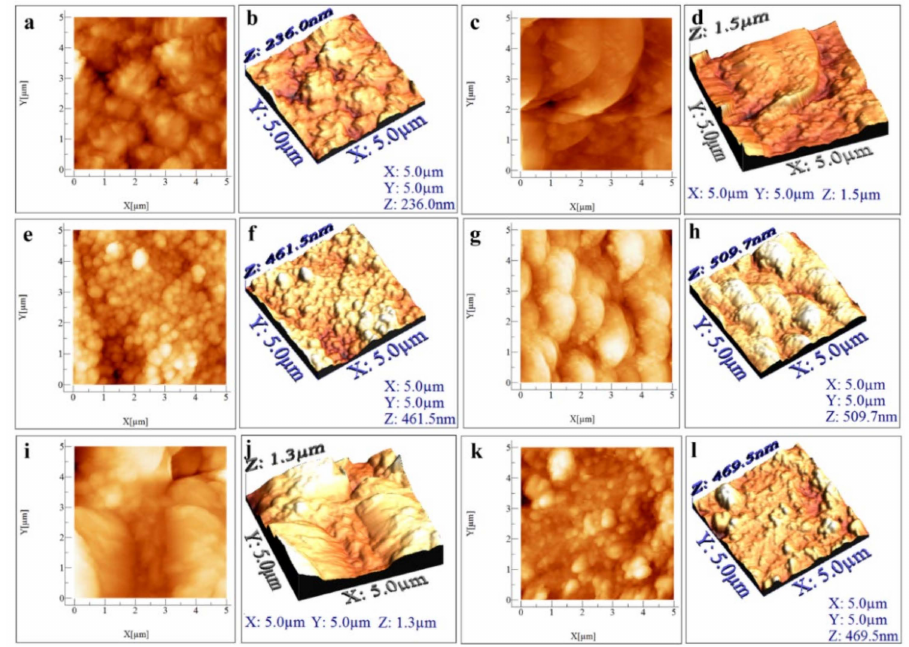
Figure 5. 5 µ m × 5 µ m 2D AFM micrographs obtained for the HA1 ( a ), HA2 ( c ), HA3 ( e ), HA4 ( g ), HA5 ( i ), and HA6 ( k ) samples and their respective 3D representations ( b , d , f , h , j , l ).